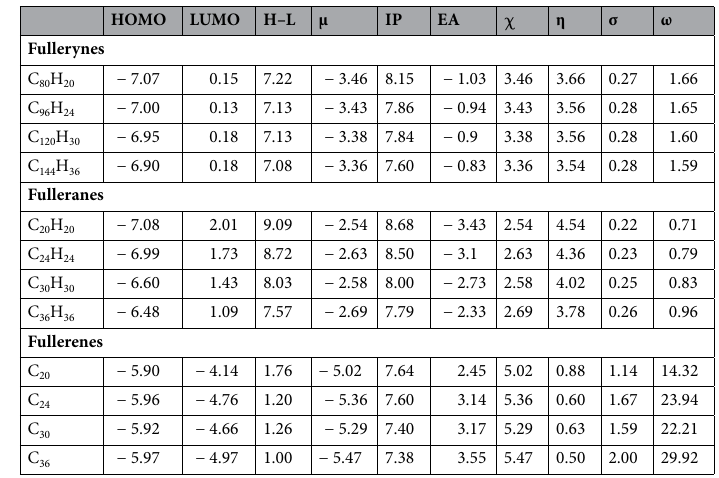
Table 2. Electronic properties of the introduced fullerynes and the corresponding fulleranes and fullerenes (in units eV).